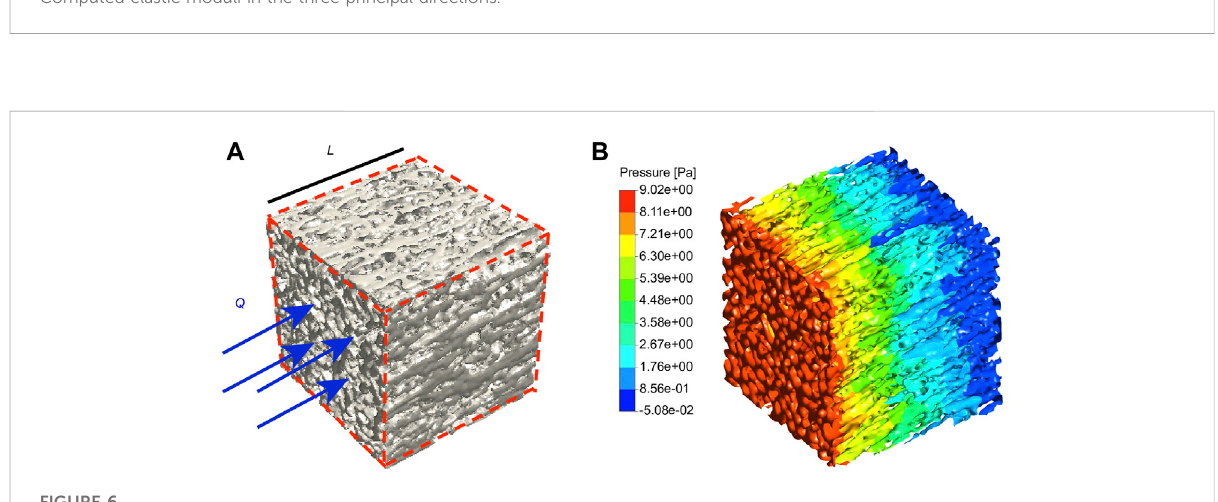
FIGURE 6 Fluid fl ow simulation. (A) The eECM RVE considered in the CFD simulations is subject to a mass fl ow rate of Q . (B) The contour of the fl uid pressure in the eECM RVE is obtained from CFD simulations. n = 3.